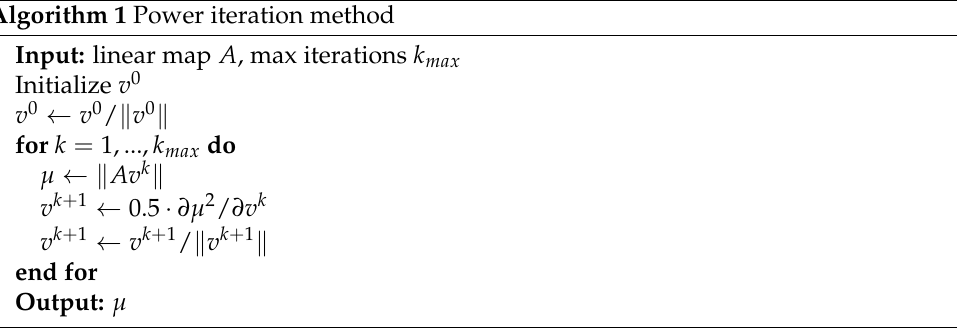
Algorithm 1 Power iteration